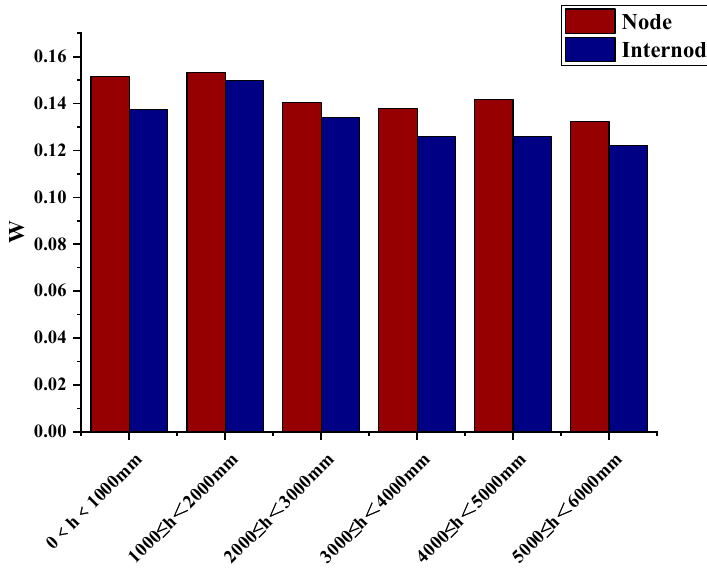
Figure 6. Statistics of the average moisture content of the specimens.